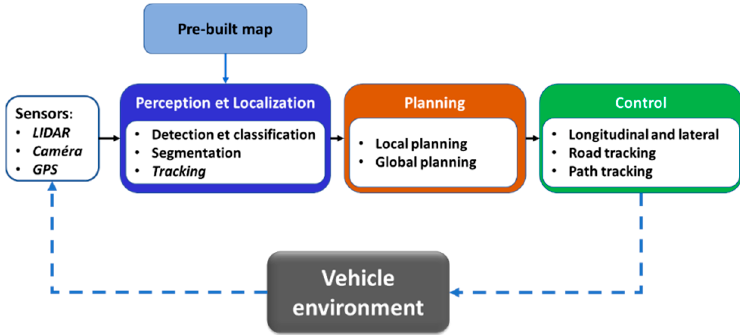
Figure 1. Modular architecture of automated driving system.